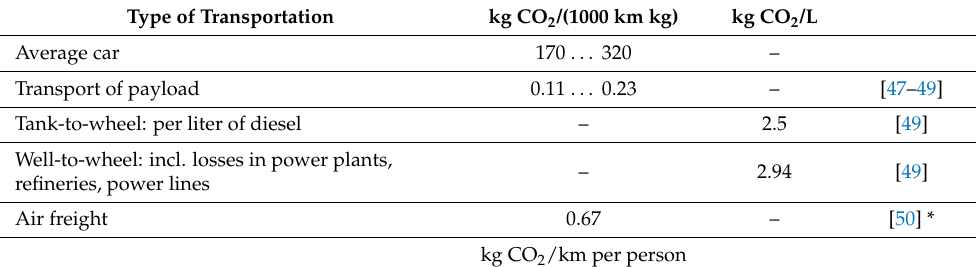
Table 3. CO 2 equivalents for the transportation of goods including climate